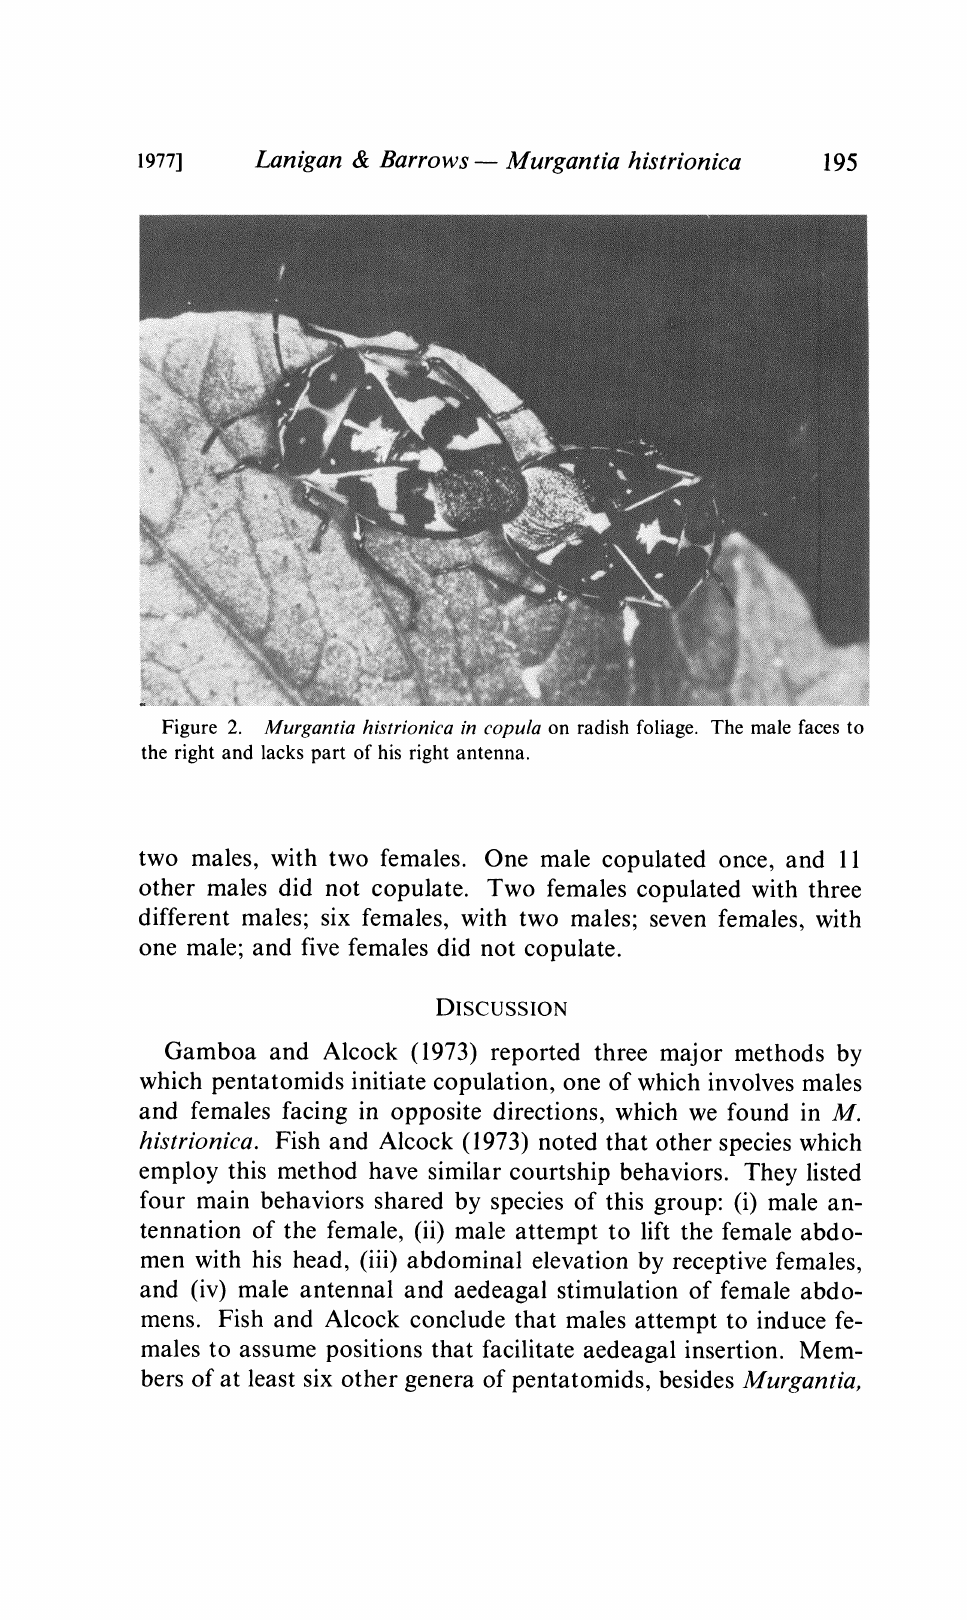
Figure 2. Murgantia histrionica in copula on radish foliage. The male faces to the right and lacks part of his right antenna.